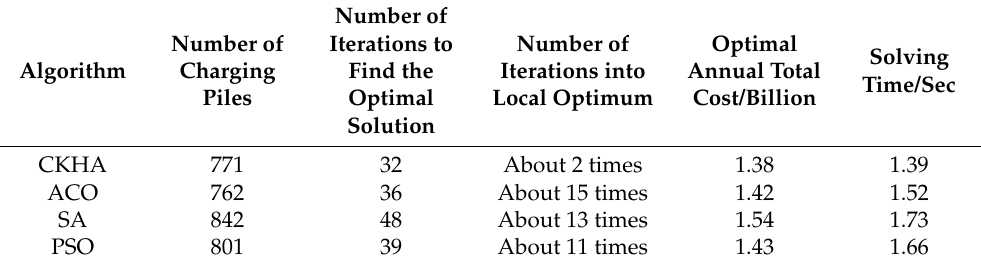
Table 4. Comparison of the results of four optimization algorithms.